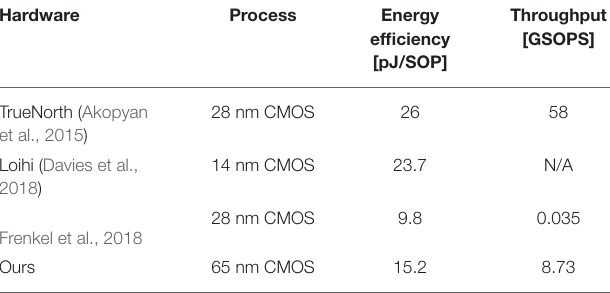
TABLE 1 | Comparison with other neuromorphic hardware systems in terms of energy efficiency and throughput. Hardware